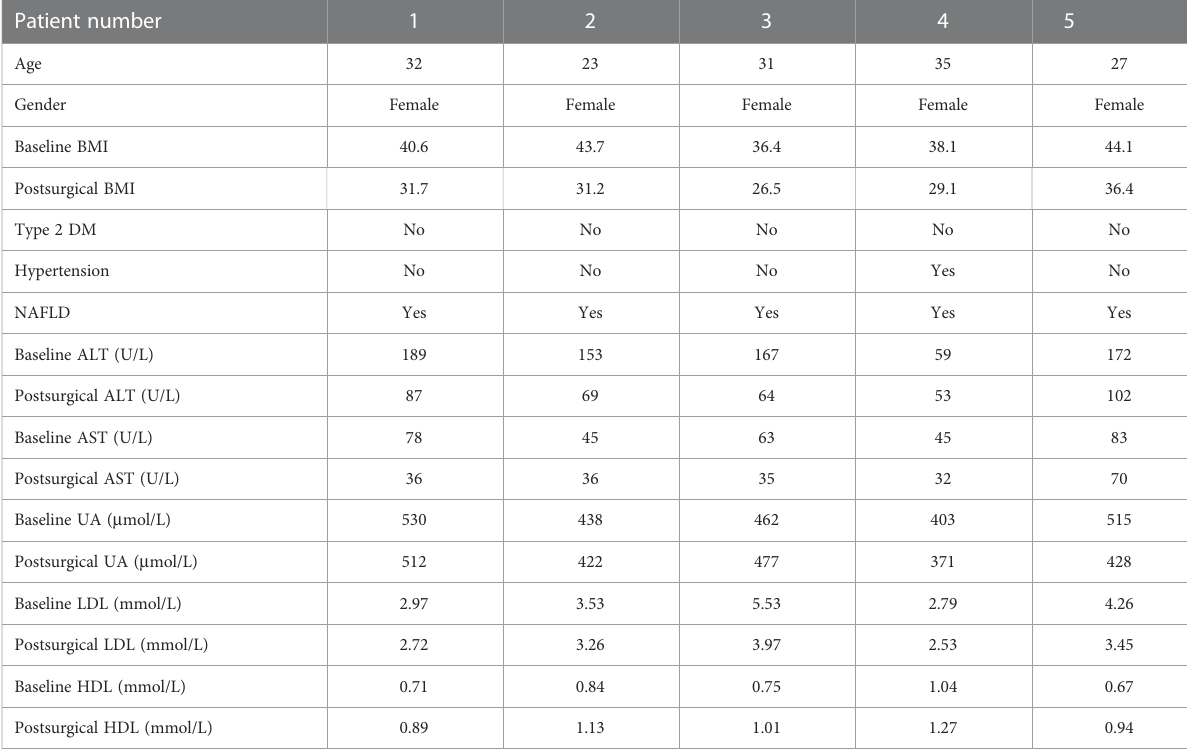
TABLE 1 Clinical baselines and characteristics before and 3 months after